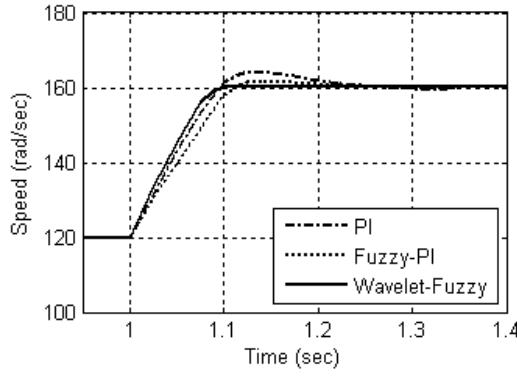
Fig. 7. Simulated starting response for a set speed of 180 rad/sec (a) PI controller (b) Fuzzy-PI controller (c) Proposed Wavelet-Fuzzy Controller.